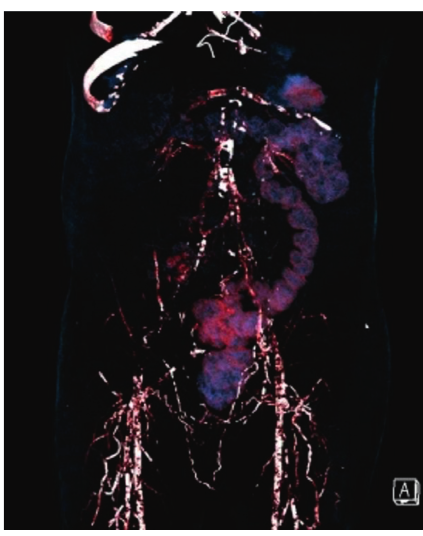
Figure 2: Volume-rendering technique image of the abdominal CT scan showing extensive vascular calcification.